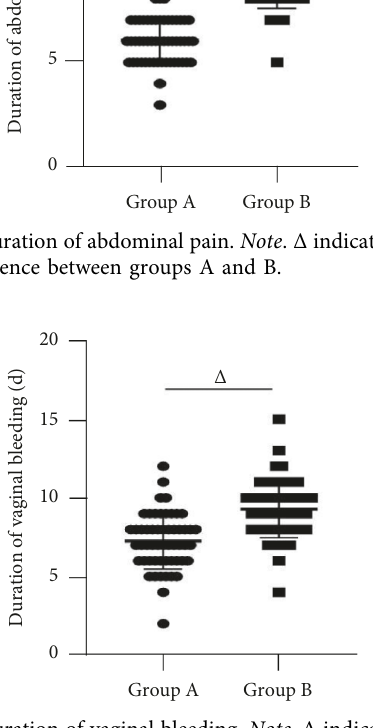
Figure 2: Duration of vaginal bleeding. Note . Δ indicates P < 0 . 05 for the difference between groups A and B.